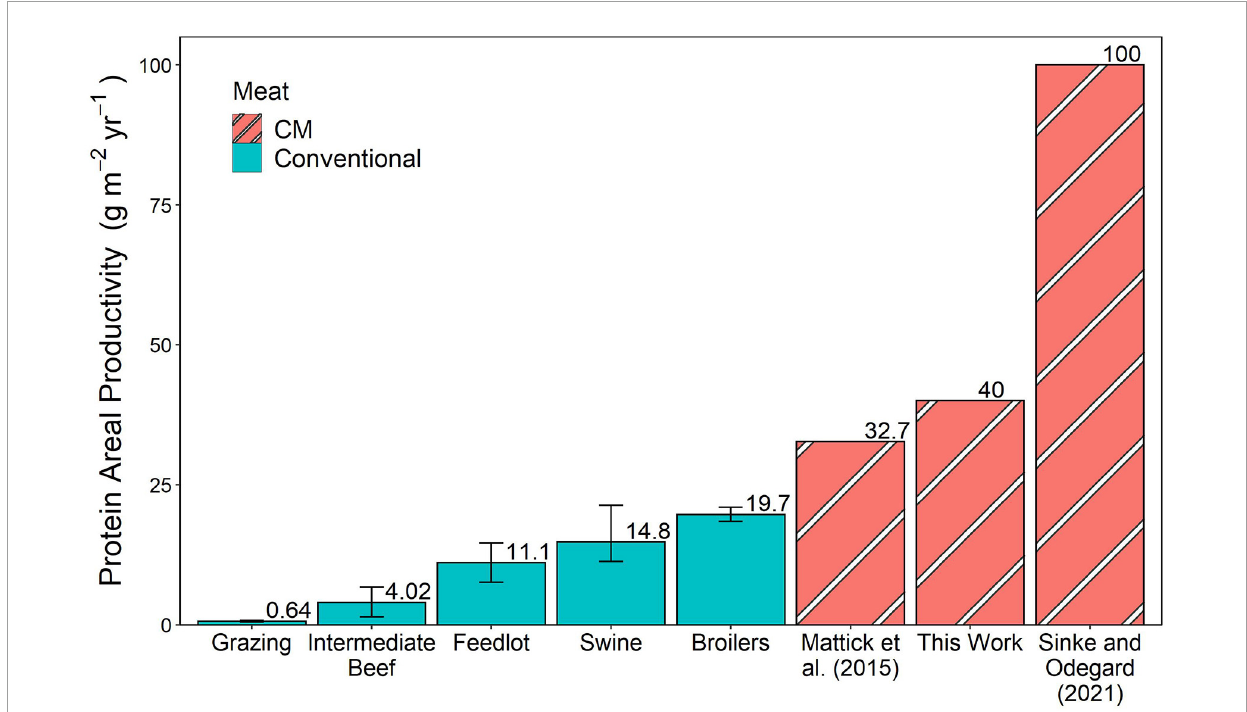
FIGURE3 Protein areal productivity in this calculated in this work, calculated from published land uses in CM life cycle analyses, and from published land uses of conventional meat products shown in g protein m - 2 year - 1 . Error bars represent the range of published land use values in conventional meat production.